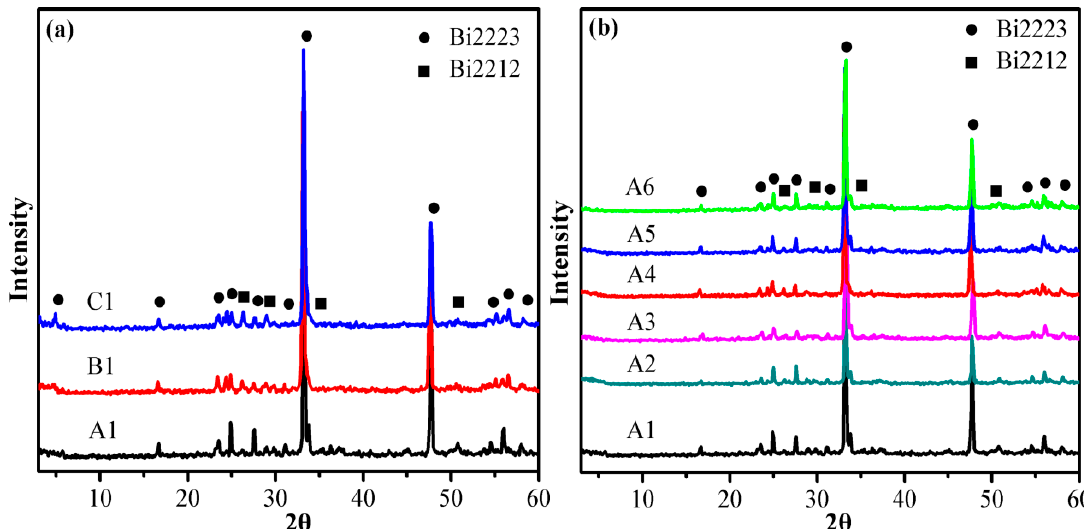
Figure 2. XRD patterns of samples. ( a ) XRD patterns of pure B(P)SCCO A1, B1, and C1 prepared by the raw materials S1, S2, and S3. ( b ) XRD patterns of pure B(P)SCCO (A1) and B(P)SCCO doped with 0.2 wt% Y 2 O 3 :Sm 3+ (A2), 0.2 wt% Y 2 O 3 (A3), 0.2 wt% Y 2 O 3 :Eu 3+ (A4), 0.2 wt% Y 2 O 3 :Eu 3+ +Ag (A5), and 0.3 wt% Y 2 O 3 :Eu 3+ +Ag (A6).